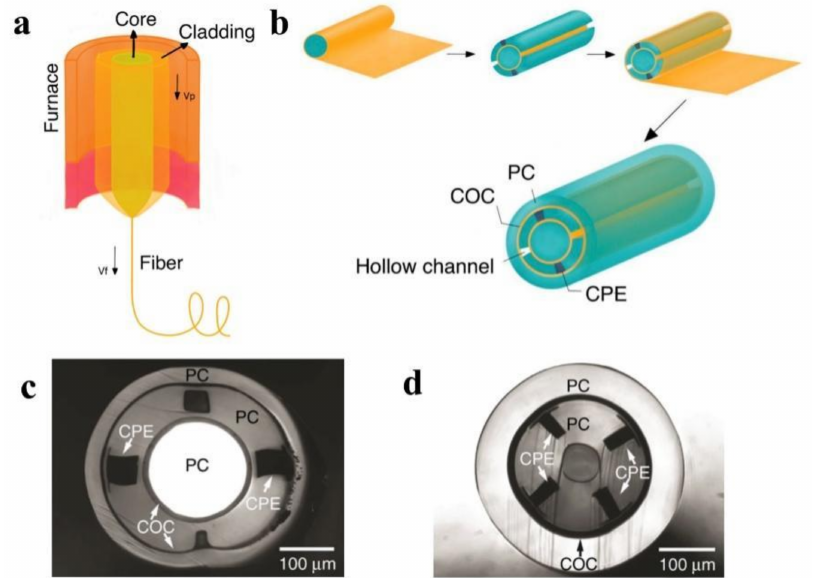
Figure 3. ( a ) A schematic of the thermal drawing process. (Adapted from ref. [132]). ( b ) A schematic of the preform fabrication process of design I. (Adapted from ref. [55]). ( c ) A cross-sectional optical image of design I, which has one cylindrical waveguide, two electrodes, and two microfluidic channels. (Reprinted with permission from ref. [40]). ( d ) A cross-sectional optical image of design II, which has one surrounding waveguide, four electrodes, and one microfluidic channel. (Reprinted with permission from ref.